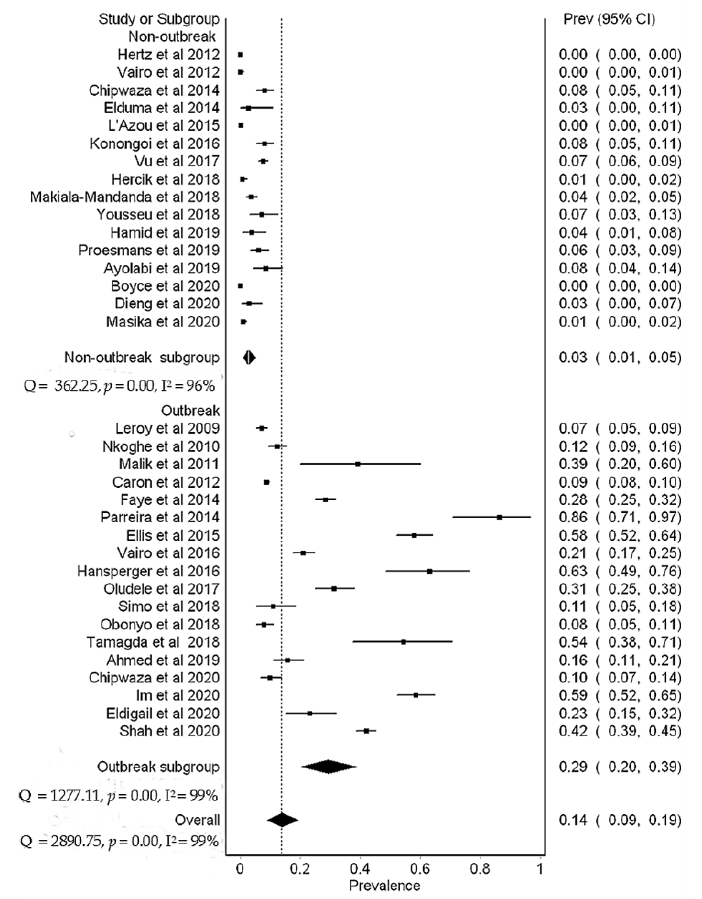
Figure 6. A subgroup meta-analysis of dengue virus prevalence in febrile patients based on prospective cross-sectional studies. Table 3. Sensitivity analysis of dengue virus prevalence based on prospective cross-sectional stud- ies.